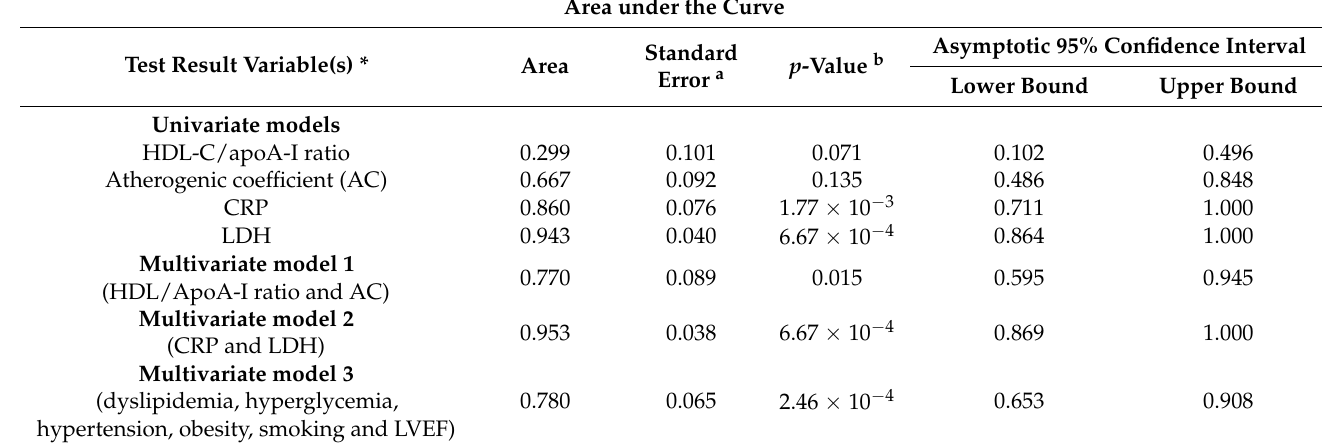
Table 2. Receiver operating characteristic (ROC) analysis for the predictive potential of univariate and multivariate (combined) models for subsequent major adverse cardiovascular events (MACE), using clinical data, HDL-C/apoA-I ratio, atherogenic coefficient (non-HDL-C/HDL-C), C-reactive protein (CRP) and lactate-dehydrogenase (LDH) values measured at hospital discharge (T 1 ) in plasma from ST-elevation myocardial infarction (STEMI) patients.